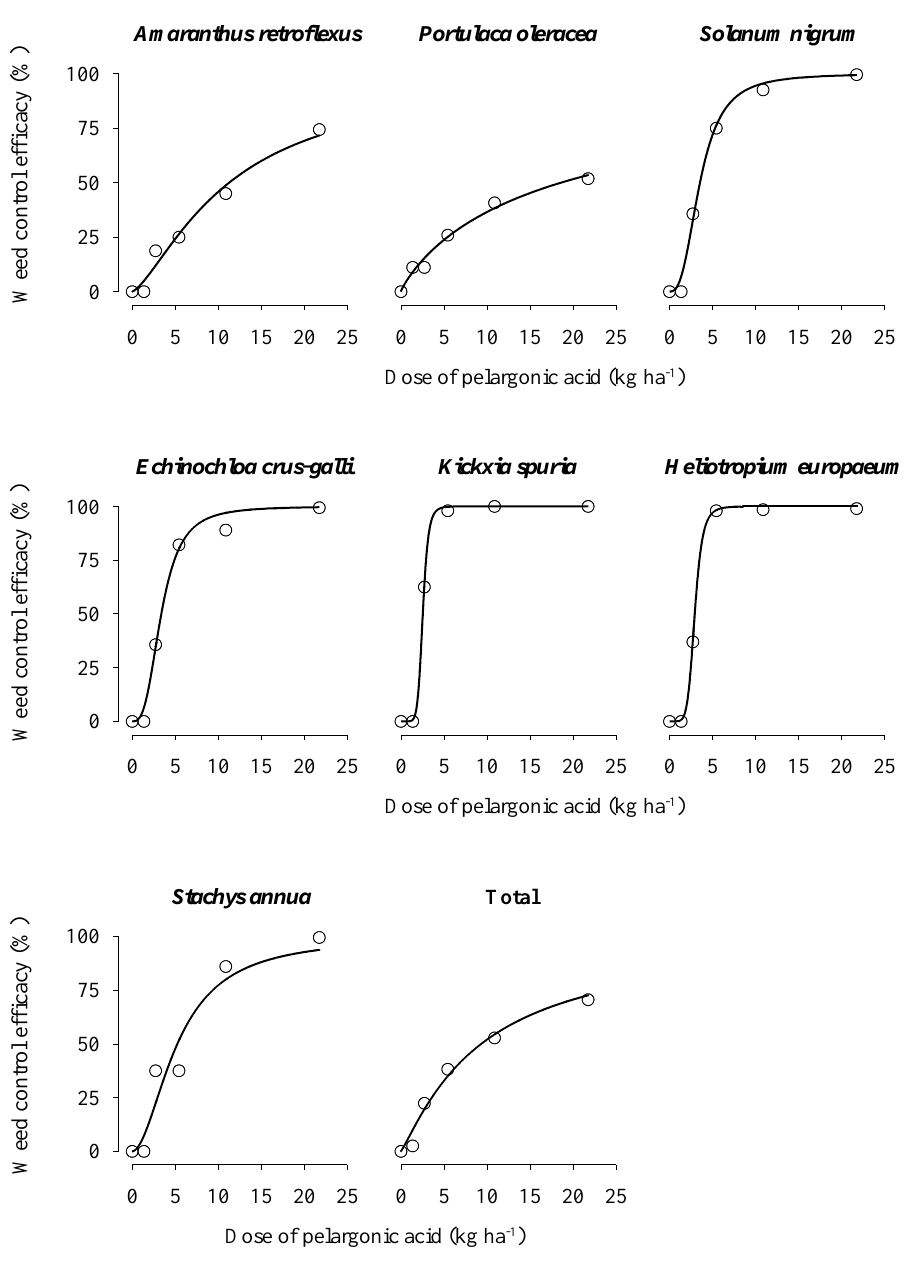
Figure 3. Dose-response curves for the efficacy of pelargonic acid against summer weed species based on their ground cover data. Symbols show observed data and lines show fitted curves according to Model [2].